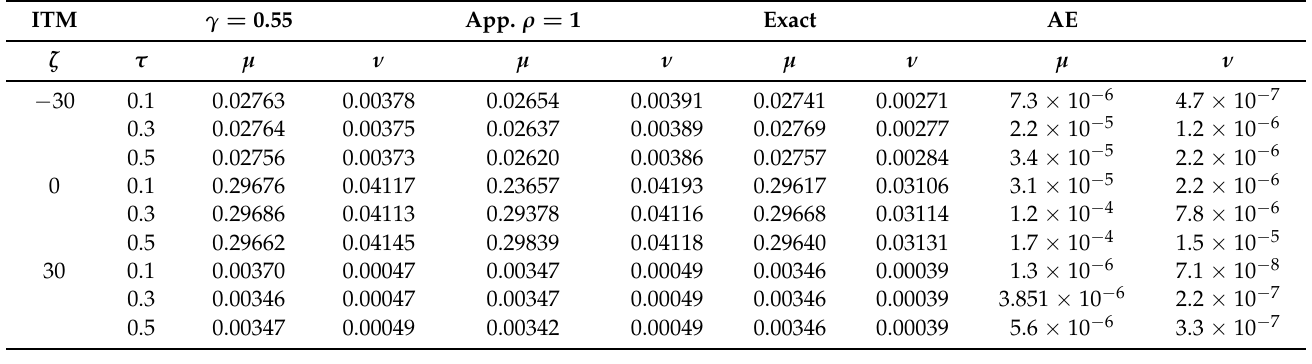
Table 1. Table of New iterative transform method for different fractional-order values of ρ when η = 0.001 and Absolute Error of example 1.